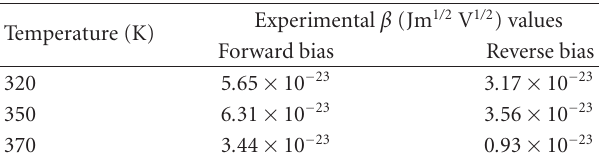
Table 2: Values of β obtained from experimental data.